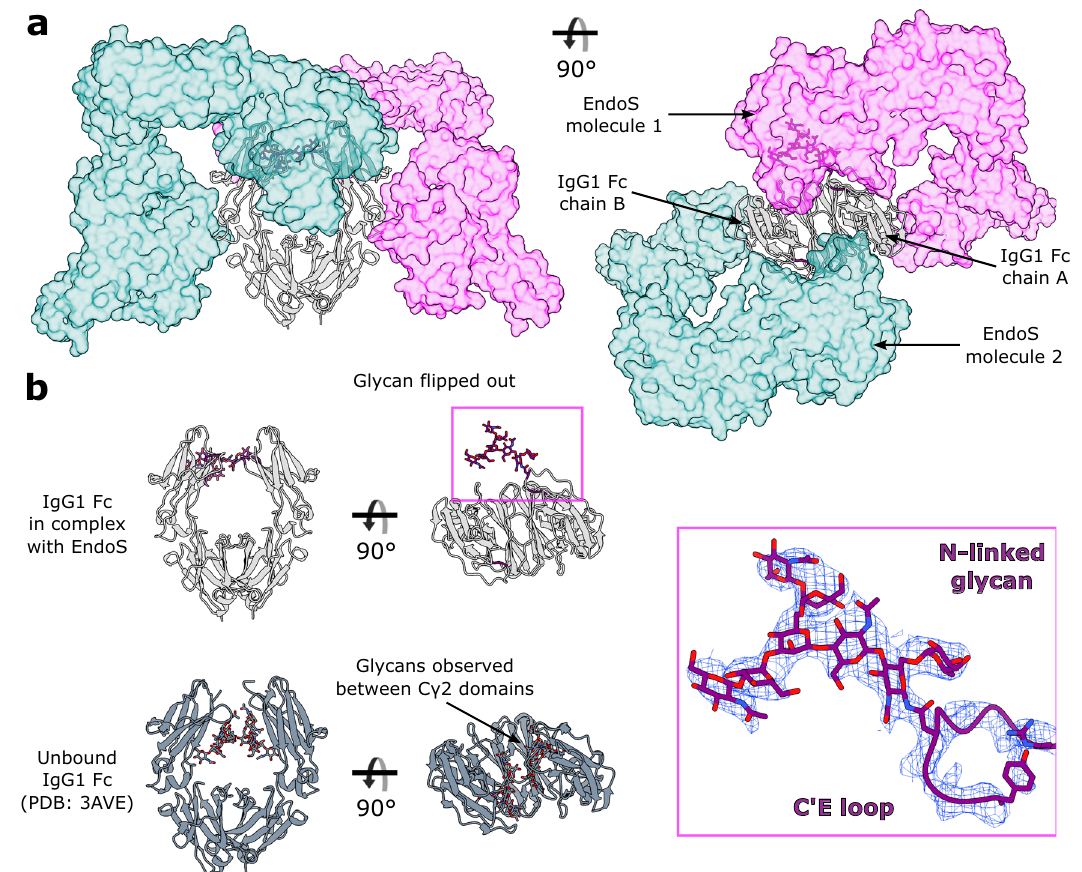
Fig. 5 | Stoichiometry of the EndoS D233A/E235L -IgG1 Fc E382R complex. a One EndoS D233A/E235L moleculeinteracts with one chain within IgG1 Fc E382R , resulting in an overall 2:2 binding stoichiometry. The two EndoS molecules are coloured teal and magenta and depicted as a surface at 50% transparency, while the Fc is coloured silver and depicted as a cartoon. C ′ E loops within the Fc are coloured purple; the N-linked glycan is depicted as sticks and coloured by heteroatom (oxygen in red